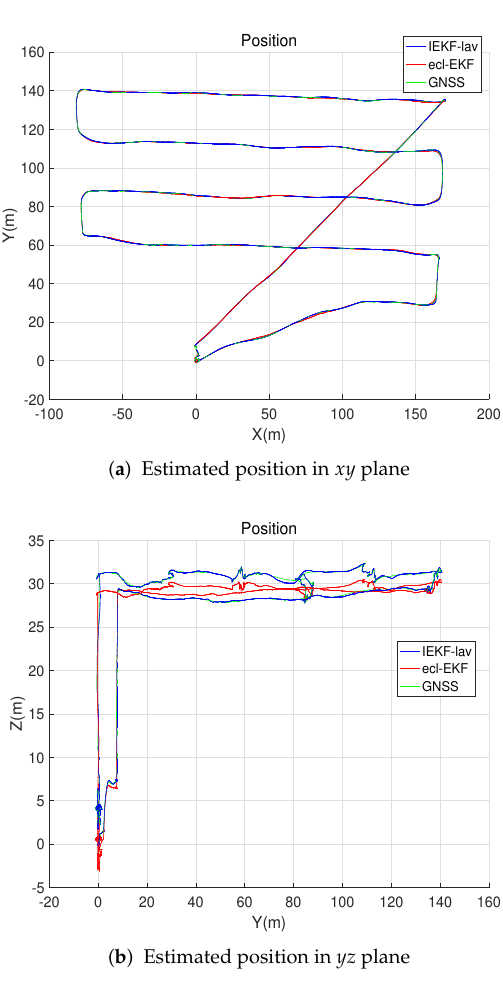
Figure 10. Robot positions estimated by IEKF-lav and ecl-EKF for quadrotor